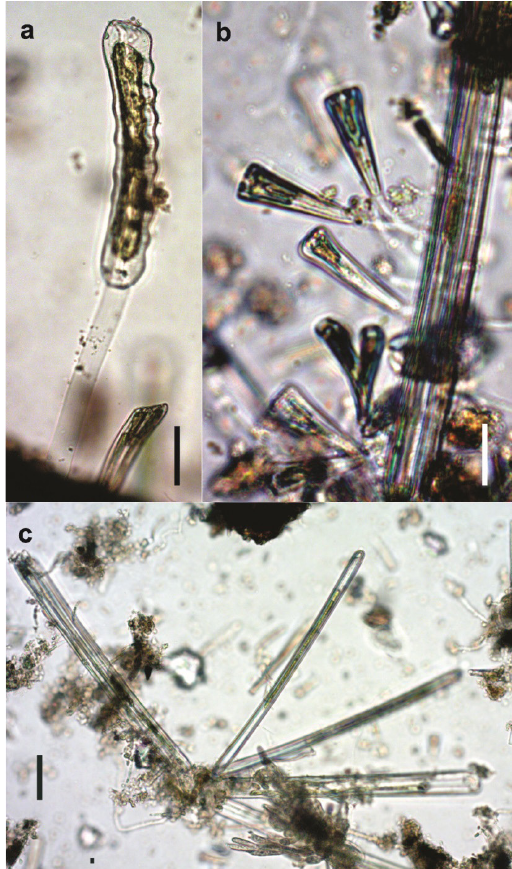
Figure 5a-c. Habitus of some Actinella species, as observed under LM. 5a. Thick stalk of A. mirabilis